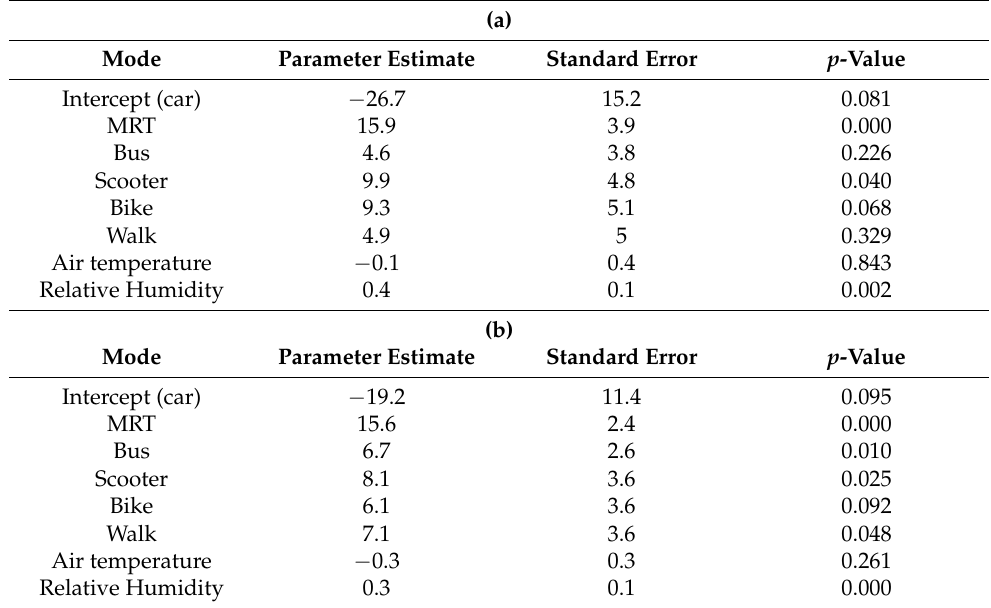
Table 2. T Hourly exposure increments ( µ g/m 3 ) from different transportation modes with ( a ) GRIMM ( n = 155, adj R 2 = 0.65) and ( b ) LASS ( n = 309, adj R 2 =